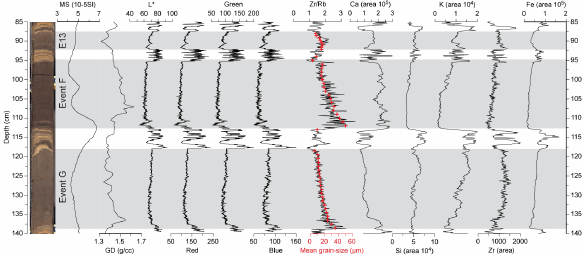
Fig. 2c. Sediment core images, Magnetic Susceptibility (MS) and Gamma Density (GD) measurements, CIE L* and RGB colour data, and main elements from XRF measurements of a 55cm long section from core LL08-2 (B1a), where 2 thick flood deposits are recorded: event E and